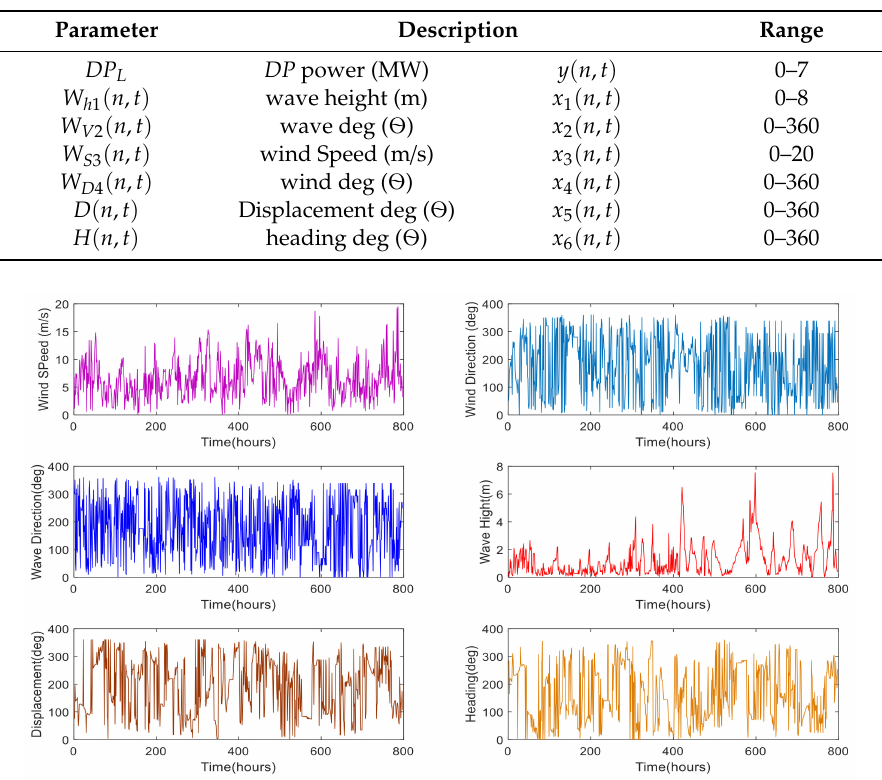
Figure 6. Historical data patterns of weather parameters, and Vessel displacement for the period one month of o ff shore operation.